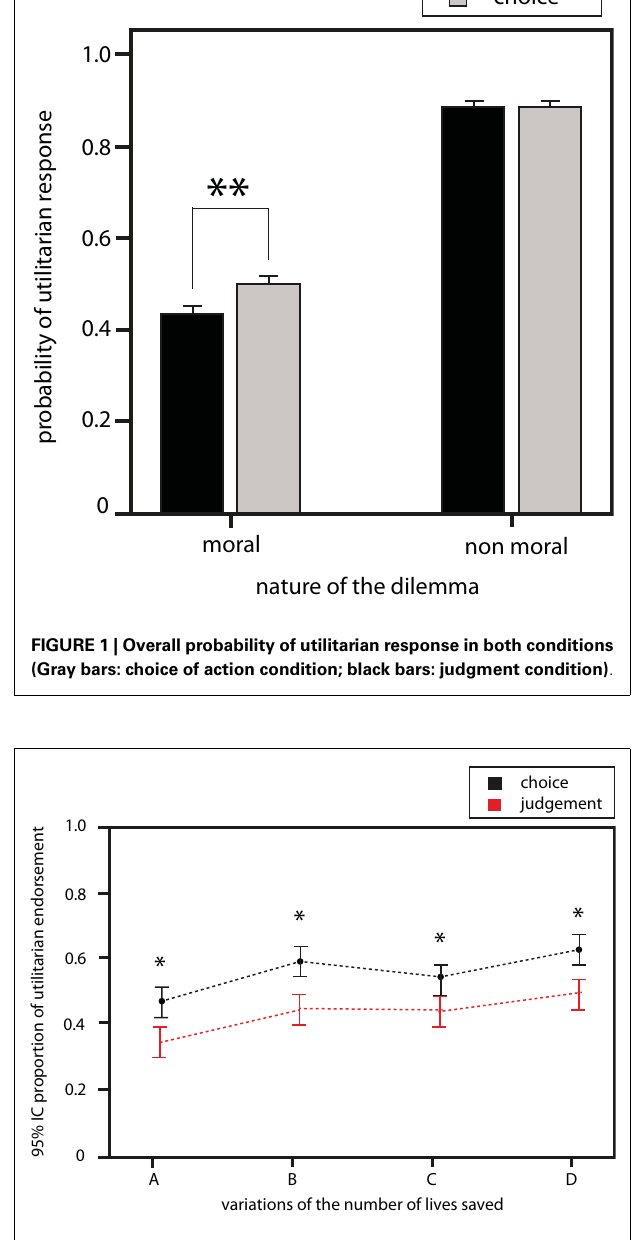
regression which revealed a significant influence of affective prox- imity on the difference of responses between judgment and choice of action [cumulative proportional odds ratio (OR) = 0.80, 95% confidence interval (0.73; 0.87); p < 0.001], proving that the effect is indeed different in both conditions. Implication of a close relative has thus a stronger influence on behavioral choice of